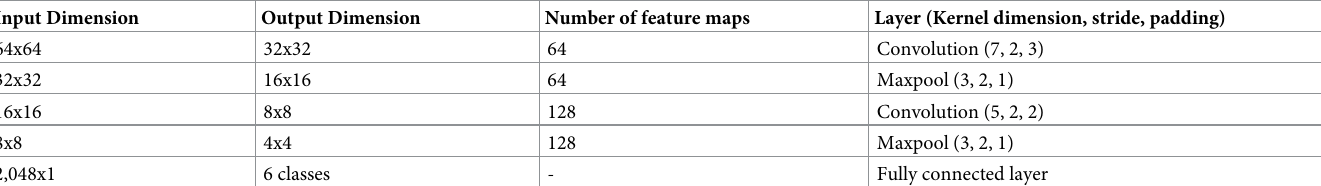
Table 4. Architecture of the Convolution Neural Network in the hierarchical classifier.